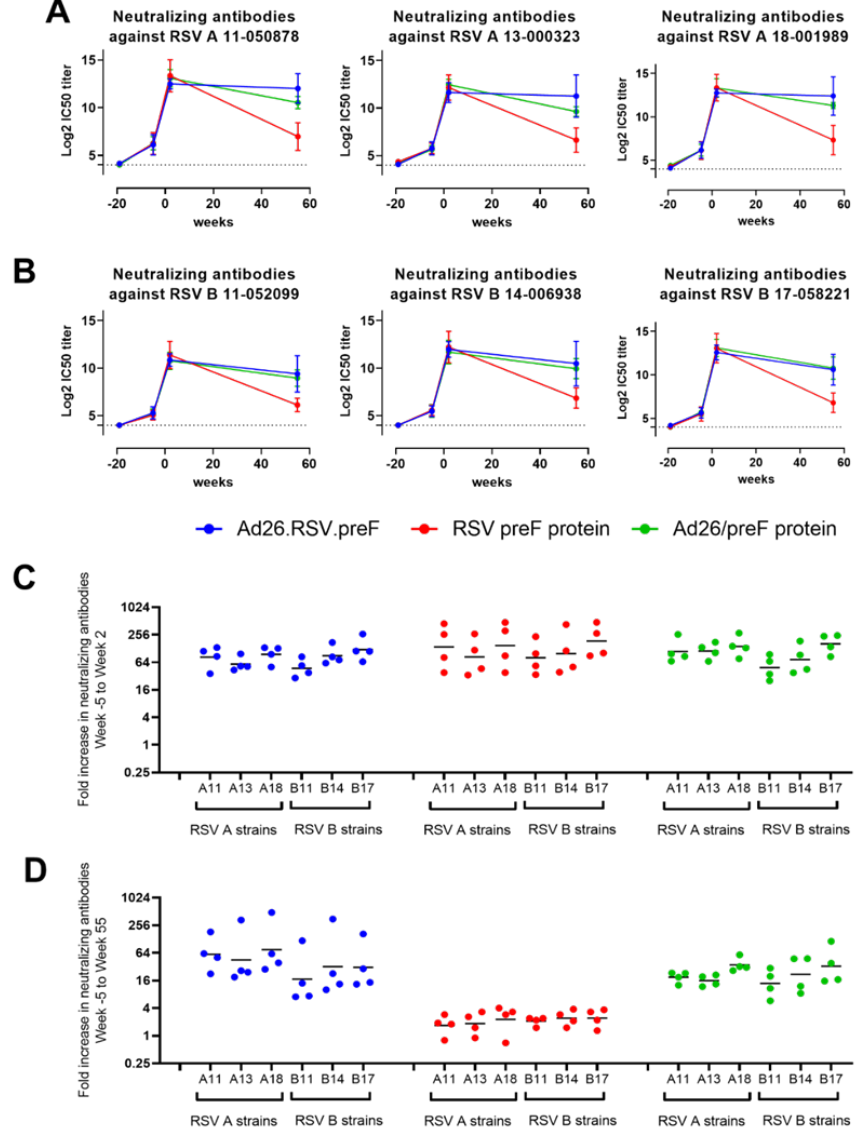
Figure 4. Ad26.RSV.preF, RSV preF protein and their combination induce antibodies that can neutralize various RSV A and RSV B strains in RSV A Memphis pre-exposed African Green Monkeys. African Green Monkeys were intranasally pre-exposed with RSV A Memphis 37 at week −19 and immunized intramuscularly at Week 0 with 10 11 vp Ad26.RSV.preF (in blue), 150 μg preF protein (in red), or a mixture of both components (in green). MN VNT against 3 RSV A strains ( A ) and 3 RSV B strains ( B ) were determined in serum samples (n = 4 per group at week −5, week 2 and week 55; one sample per group at week −19). The 50% inhibitory concentration (IC50) titers were calculated, and the limit of detection (LOD) was set at 4 log2 (dotted line), which is the lowest serum dilution used in the assay. Mean ± standard deviations are shown. Fold increase from week −5 to week 2 ( C ) or to week 55 ( D ) was calculated per animal, with geometric means per group per RSV strain indicated.